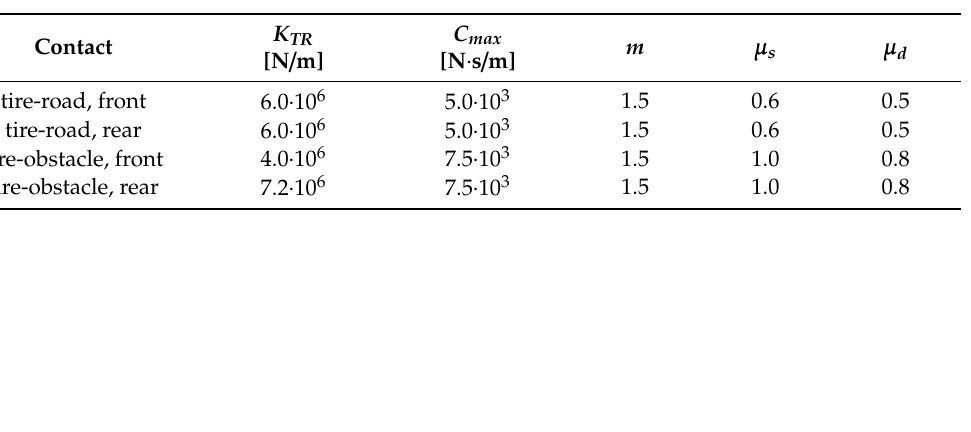
Table 2. Main tire contact force parameters of the Traigo 80 rigid-body model after